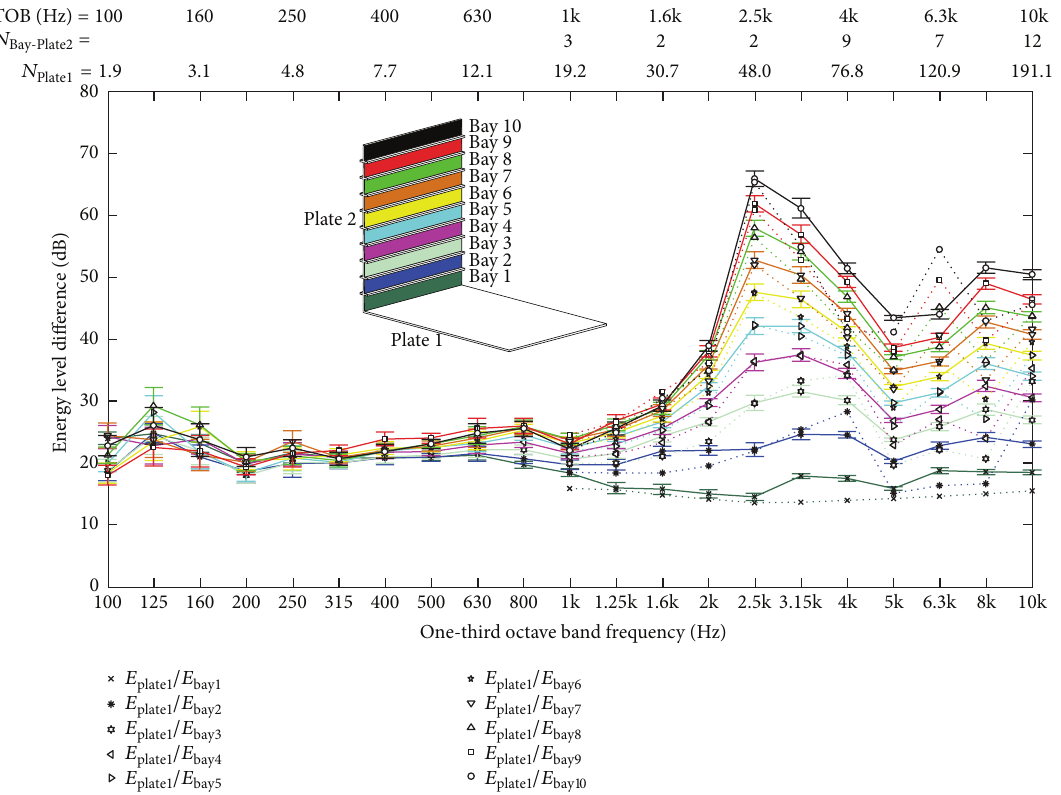
Figure 5: L-junction A. Excitation: Plate 1. Energy level differences between the isotropic, homogeneous plate (Plate 1) and each of the bays that form the periodic ribbed plate (Plate 2). Comparison between FEM and ASEA (FEM data are shown using markers with continuous lines; ASEA data are shown using markers with dotted lines). Upper 𝑥 -axis indicates the mode counts for each bay of the ribbed plate ( 𝑁 and Plate 1 ( 𝑁 Plate1